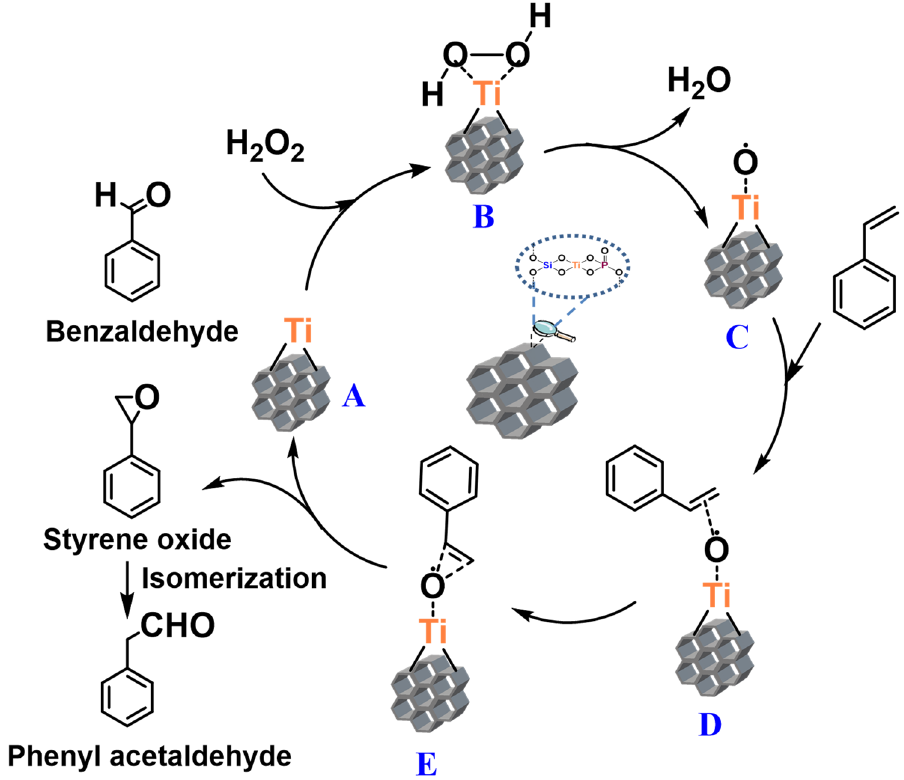
Figure 3. Plausible mechanistic pathway of styrene oxidation over STP − 1.